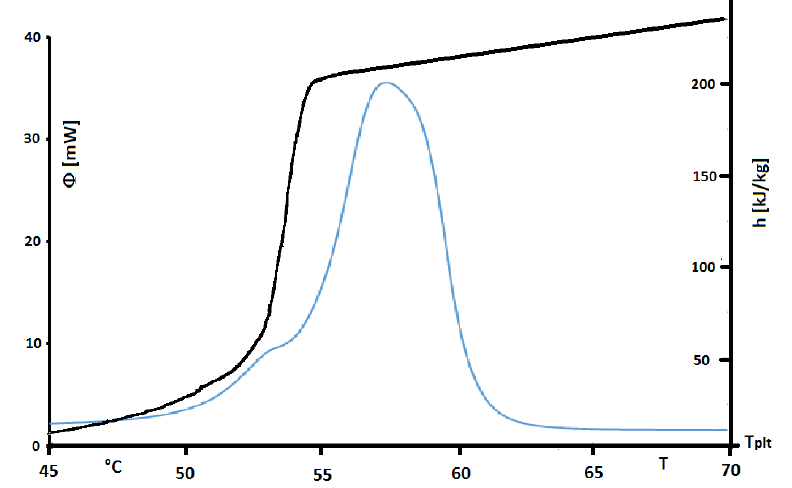
Figure 33. Enthalpy function determined by the STEP method (black) and the corresponding thermogramm at 2 K/min versus temperature for fatty acid